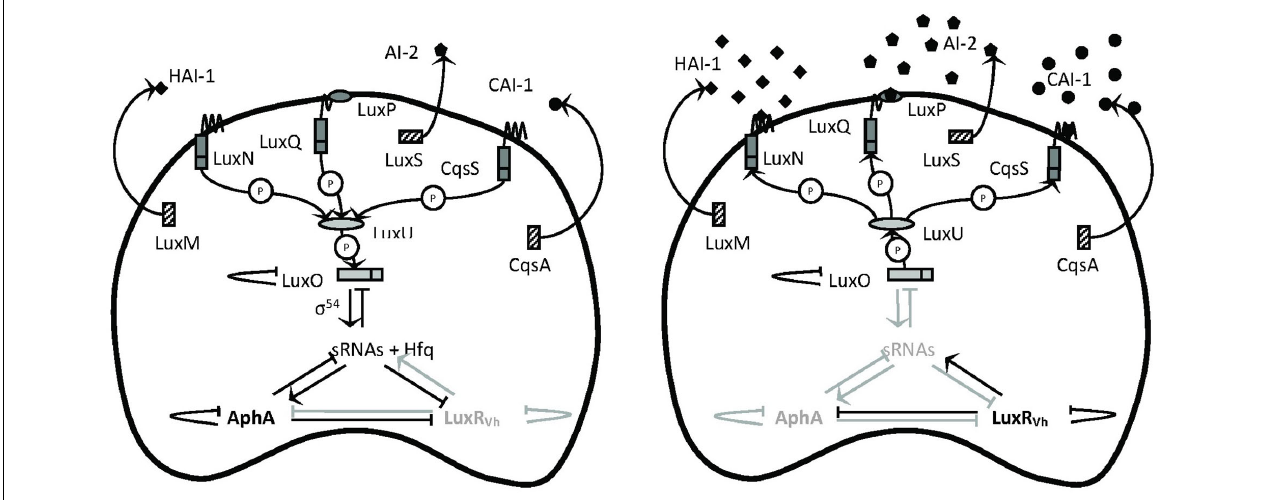
FIGURE 1 | Schematic representation of the quorum-sensing circuit of Vibrio campbellii . The LuxM, LuxS, and CqsA enzymes synthesize the autoinducers HAI-1, AI-2, and CAI-1, respectively (Winzer et al., 2002). These autoinducers are detected at the cell surface by the LuxN, LuxPQ, and CqsS two-component hybrid sensor kinase/response regulator proteins, respectively. In complex of AI-2 by LuxQ requires the interacts with the periplasmic protein LuxP to send the AI-2 signal (Bassler et al., 1993). In the absence of autoinducers (left, at low cell density), the receptors autophosphorylate and transfer phosphate to LuxO via LuxU (Freeman and Bassler, 1999). Phosphorylation activates LuxO, which together with σ 54 activates the production of five small regulatory RNAs (sRNAs). The sRNAs, together with the chaperone Hfq, promote translation of the master regulator AphA and inhibit translation of the master regulator LuxR Vh (Tu and Bassler, 2007). In the presence of high concentrations of the autoinducers (right, at high cell density), the receptor proteins switch from kinases to phosphatases, which results in dephosphorylation of LuxO. Dephosphorylated LuxO is inactive and therefore, the sRNAs are not formed, AphA is not translated, and LuxR Vh is translated. AphA and LuxR are transcriptional regulators that (either individually or together) affect the transcription of many target genes. P means phosphotransfer. Modified with permission from Defoirdt et al. (2008) and Yang et al. (2017).